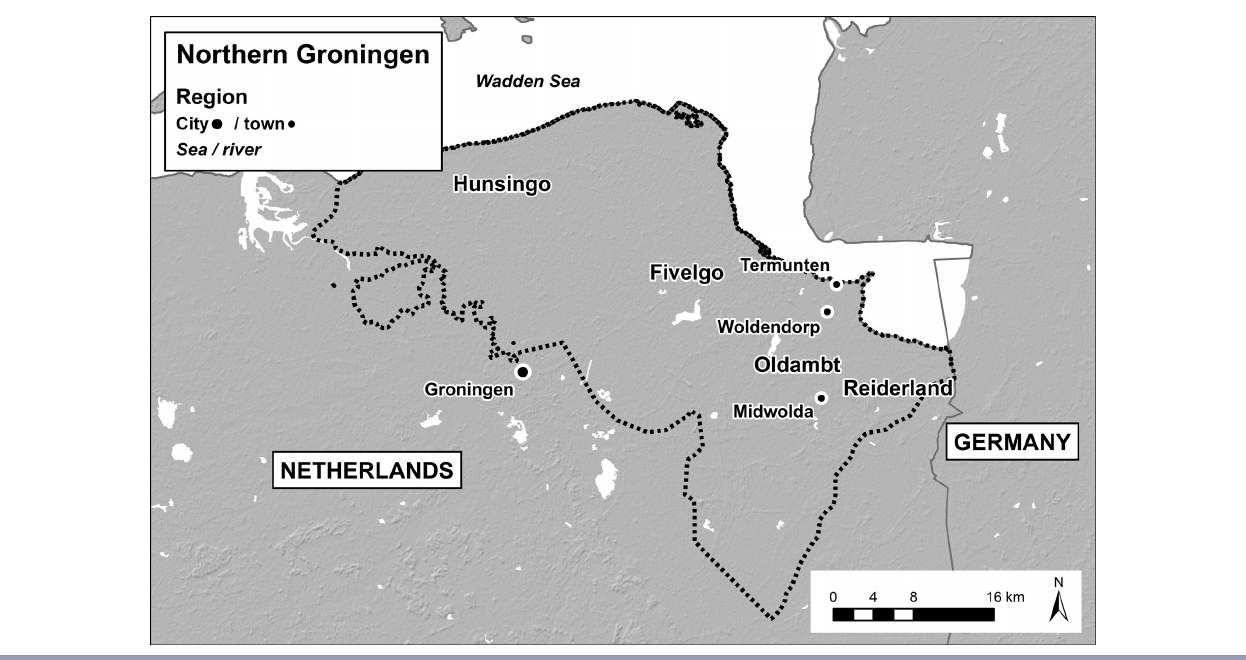
Fig. 4 . Map of Northern Groningen, indicating the localities mentioned in the text. Iason Jongepier, GIStorical Antwerp (UAntwerpen/Hercules